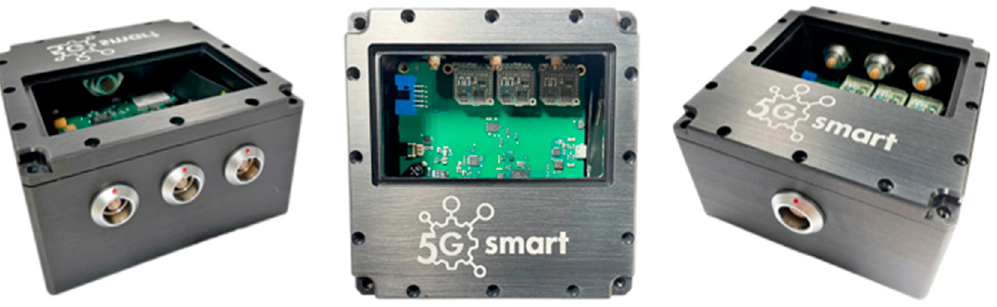
Figure 1. MSP prototype.